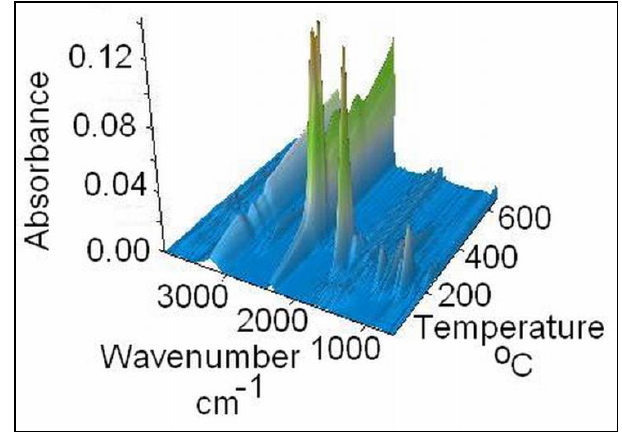
Figure 5. FTIR–3D spectrum of PITAU–Alg gel structure.